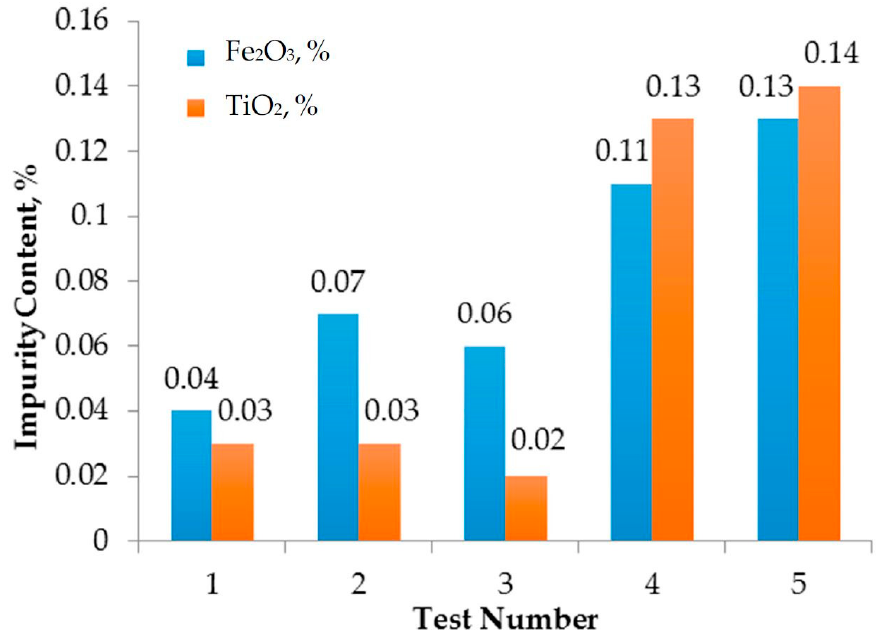
Figure 5. Impurity content of feldspar concentrates for each test.